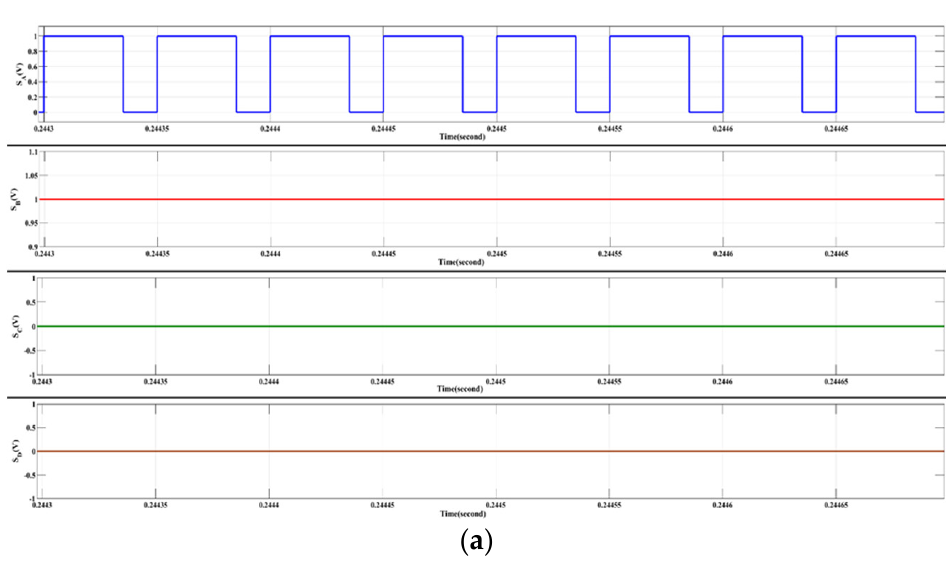
( b ) Figure 6. Simulation result of the proposed IIABB converter for solar PV module input voltage V pv of 20 V and corresponding output voltage V o = 48 V and number of connected inductors N = 1 with duty cycle 0.7 ( a ) gate pulse waveform where S A and S B are in operating condition and S C and S D are not operating, and ( b ) the V pv and output voltage V o . When the solar PV module output voltage of V pv 20 V is applied with a duty cycle of 0.7, an output voltage of 48 V is achieved, as shown in Figure 6b for the use of ba tt ery charge. Condition 2: Figure 7 shows the simulation results of the proposed IIABB converter for V pv of 20 V and N = 2. Figure 7a shows the switching modulation of the gate pulse of four switches with switches S A and S C in conduction mode, whereas S B and S D are not conducting, and the duty cycle of the power MOSFET S A is calculated to be 0.55 by choosing the value of N = 2 with the help of Equation (11). When V pv = 20 V is applied with a duty cycle of 0.55, an output voltage of 48 V is achieved, as shown in Figure 7b for the use of ba tt ery charge.